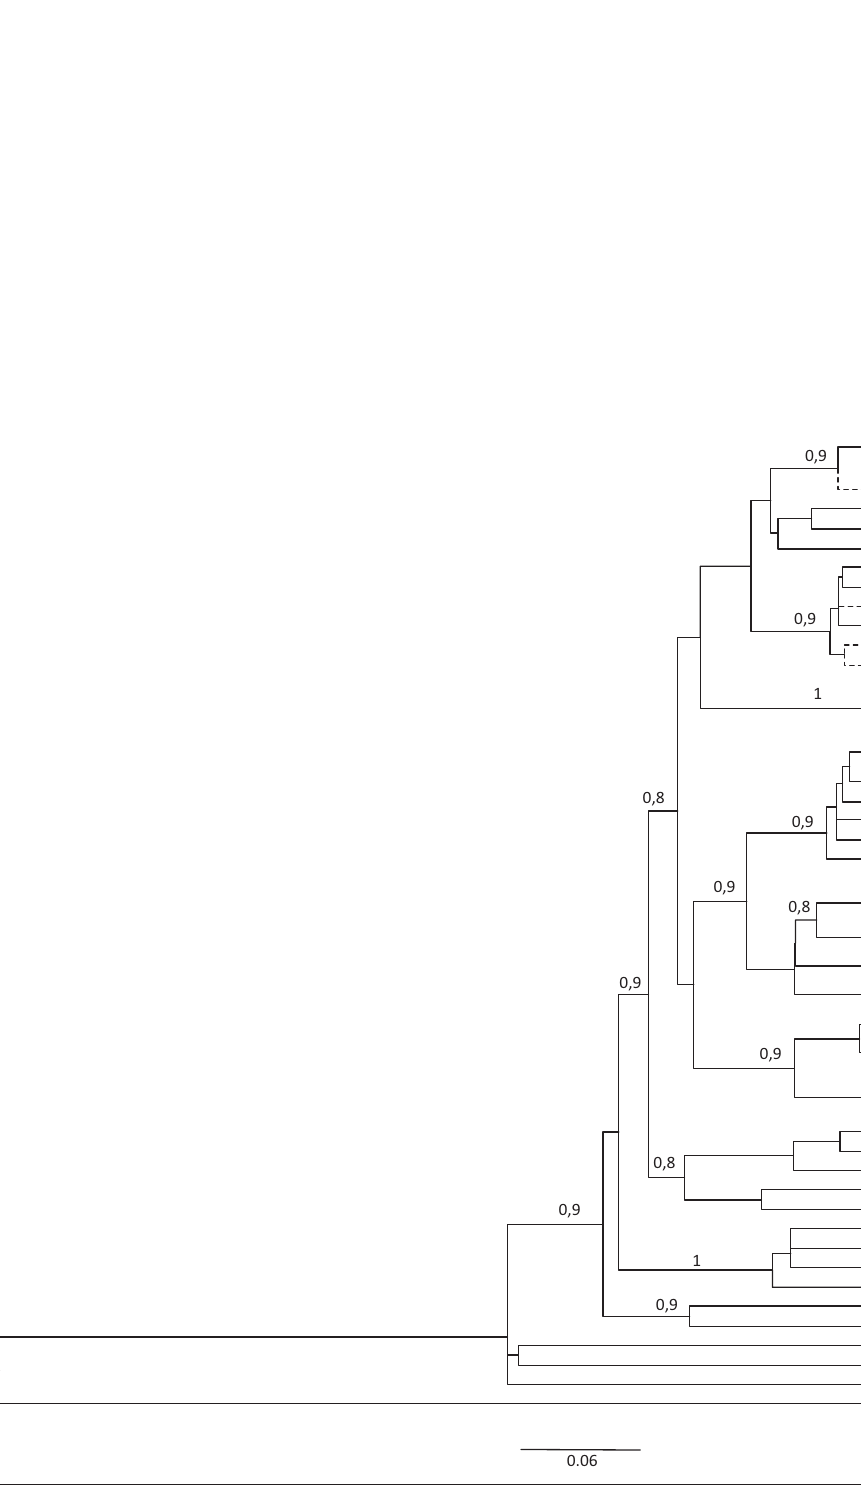
FIGURE 3: Arbre PhyML montrant la relation phylogénétique entre les séquences requêtes ( n = 28, en traits pointillés) et les références (en traits pleins) dans la région du gène pol (PR+RT) du